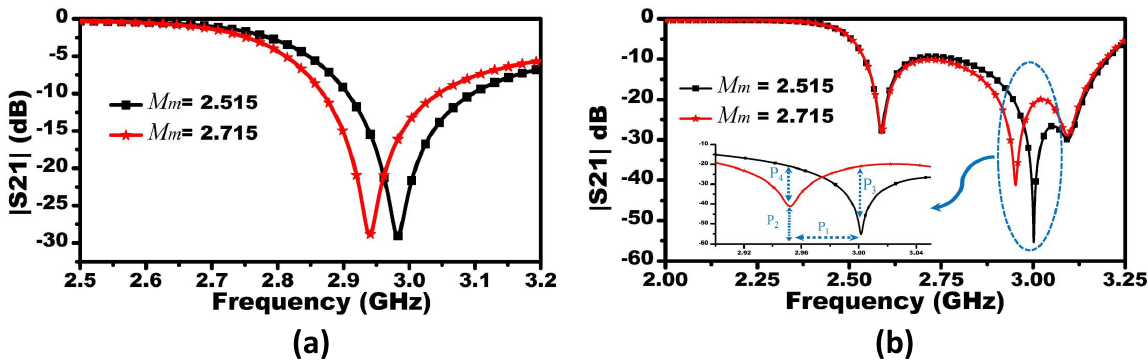
Figure 7. The scattering parameter | S 21 | of the system obtained from the full-wave numerical simulation. The resonators A and C are loaded with 4.806 and 2.015, respectively, while resonator B is loaded with material having permittivity varying from 2.015 to 4.806 in increments of 0.05 producing 57 curves. The plot is corresponding only to some selected variation for the purpose of making the curves clear.